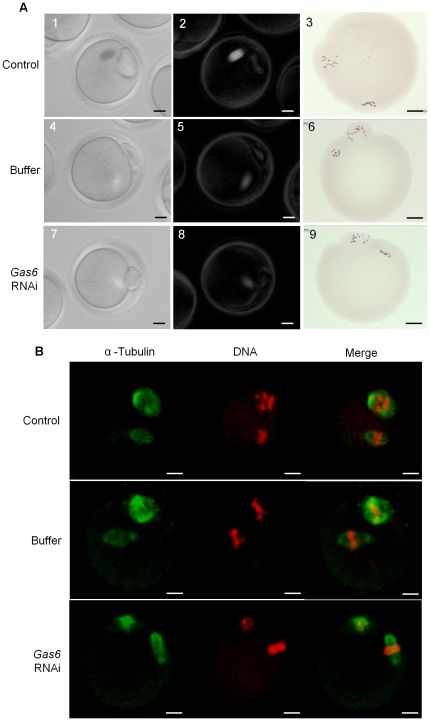

Gas6 is not required for spindle and chromosomal dynamics in meiotic cell cycle.(A) Microphotographs in the left panel (1, 4, 7) show the oocytes under bright field, whereas microphotographs in the middle panel (2, 5, 8) show the noninvasive analysis of spindle structure in same oocytes using Polscope. Microphotographs in the right panel (3, 6, 9) show the results of aceto-orcein staining of chromosomes in MII oocytes. (B) Immunofluorescence staining for spindle and chromosome morphology in control and Gas6 dsRNA-injected oocytes matured in vitro. MII oocytes were fixed in 4% paraformaldehyde, stained with α-tubulin antibody (Green), and counterstained with propidium iodide (Red) for DNA staining. Scale bars indicate 25 µm.